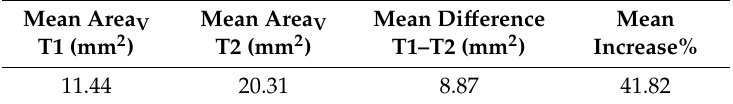
Table 5. Mean of the vestibular areas calculated by using IMAGEJ at T1 (2 months) and T2 (4 months); the mean di ff erences between the size of the vestibular areas at 2 and 4 months and their mean percentage increase.